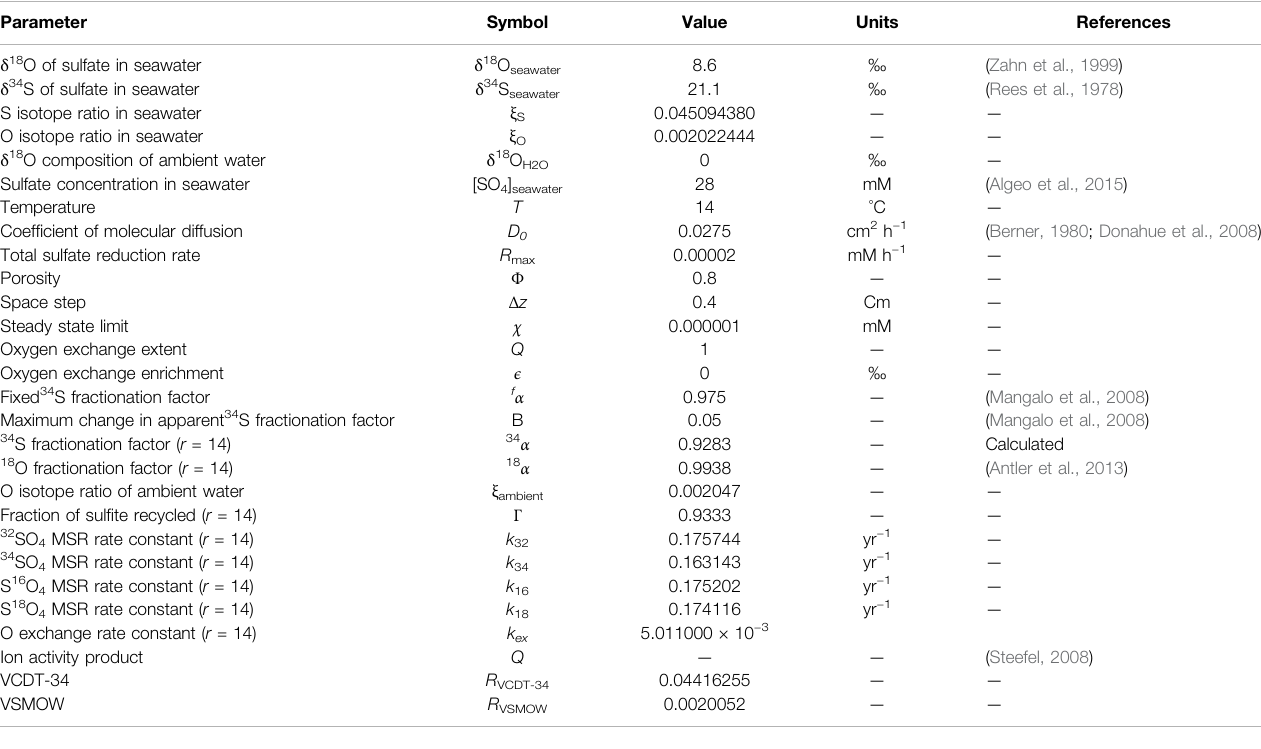
TABLE 1| Alist ofmodel parameters andvalues.Inthecases wheretheparameter has adependenceonthevalueofr,wehave used r (cid:2) 14asasuitableintermediatevalue that has been suggested to exist in natural environments (Horner and Connick, 2003; Wortmann et al., 2007; Müller, 2013; Wankel et al., 2014).